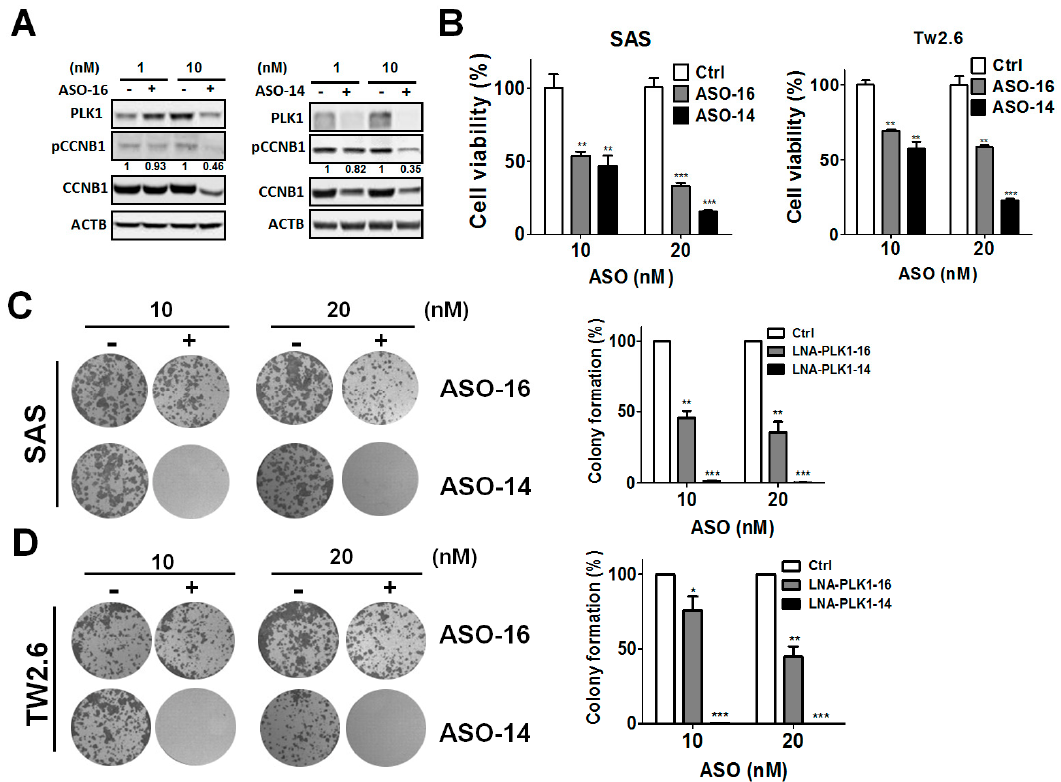
Figure 3. Effects of antisense oligonucleotides against PLK1 (polo-like kinase 1) on the proliferation of OSCC (oral squamous cell carcinoma) cells. ( A ) Human oral cancer SAS cells were transfected with antisense oligonucleotides (ASO-16 and ASO-14) against PLK1 for 48 h. The knockdown efficiency of PLK1 and the effects of its downstream protein, cyclin B1 (CCNB1), in the cells were examined by immunoblotting. ( B ) SAS and TW2.6 cells were transfected with ASO-16 or ASO-14 (10 and 20 nM) for 72 h, and cell proliferation was measured with the CellTiter-Glo assay (Promega). The quantitative results for (A) are expressed as the mean ± standard error of the mean (SEM) from three independent experiments., ** p < 0.01, *** p < 0.001 vs. the non-targeting control siRNA (siCtrl). ( C ) SAS and ( D ) TW2.6 cells were transfected with ASO-16 or ASO-14 against PLK1 and cultured for 14 days. The cells were fixed and stained with crystal violet to count the number of colonies formed (left panel). The quantitative results are expressed as the mean ± SEM from three independent experiments (right panel). * p < 0.05, ** p < 0.01, *** p < 0.001 vs. the non-targeting control siRNA (siCtrl).